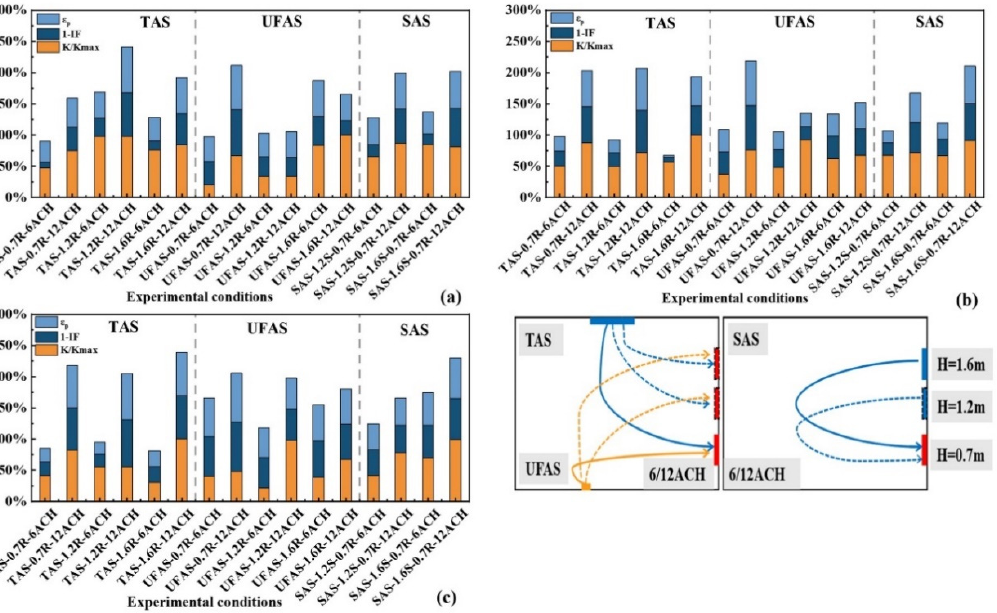
Figure 9. Evaluation indicators of different return air inlets’ heights at different distances between medical staff and patients. ( a ), ( b ) and ( c ) represent the distances between the medical staff and the medical staff and patients. ( a – c ) represent the distances between the medical staff and the patient of patient of 0.5 m, 1.0 m and 1.5 m, respectively. 0.5 m, 1.0 m and 1.5 m,